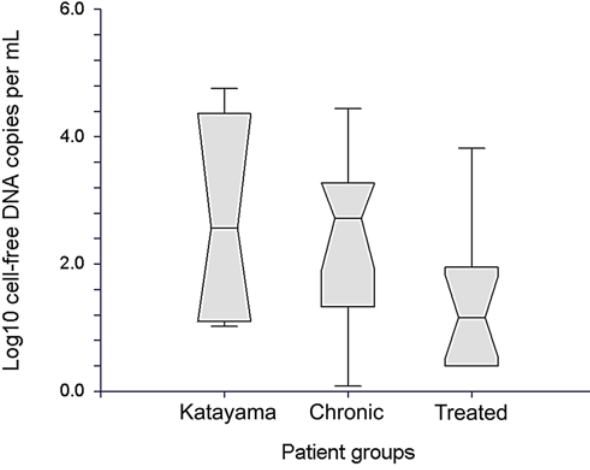
Figure 4. Box plot analysis of cell-free DNA concentrations in patients with Katayama syndrome (first visits only), patients with chronic disease, and all patients who had positive plasma PCR after treatment (pooled from treated Katayama syndrome patients and patients examined retrospectively after treat- ment). Boxes represent the innermost two quartiles (25%–75% percentiles=interquartile range, IQR) of data. The whiskers represent an extension of the 25 th or 75 th percentiles by 1.5 times the IQR. The notches represent the median + / 2 1.57 IQR ! n. If the notches of two boxes do not overlap, the medians (=notch centers) are significantly different (true for the active disease vs. the treated group).